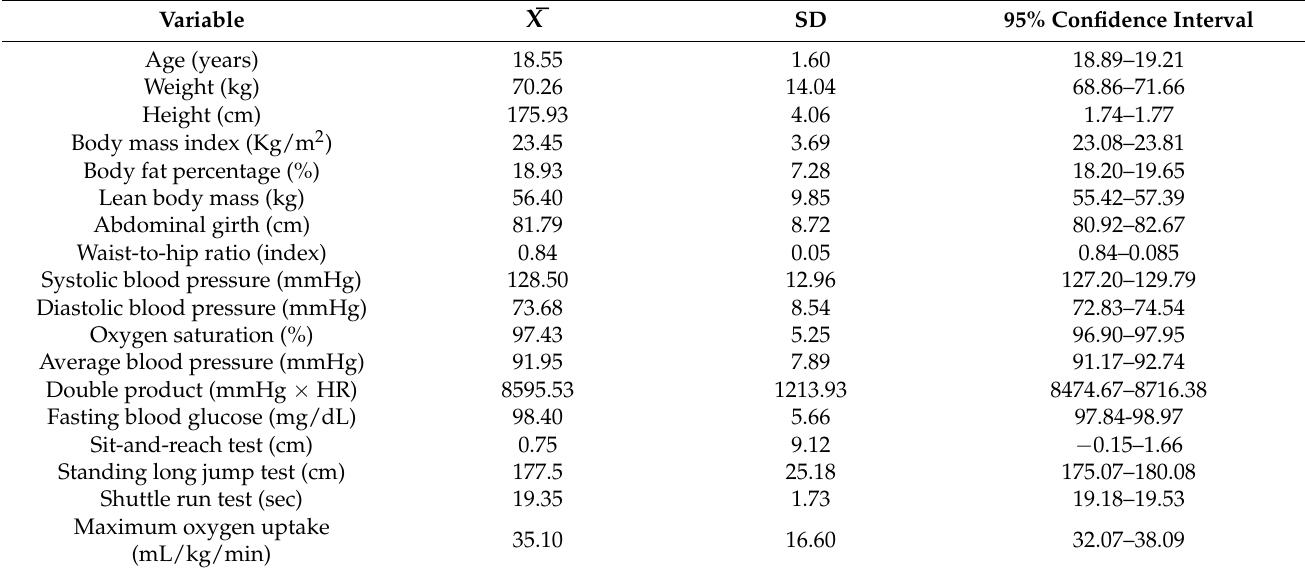
Table 2. Characteristics of the participants.